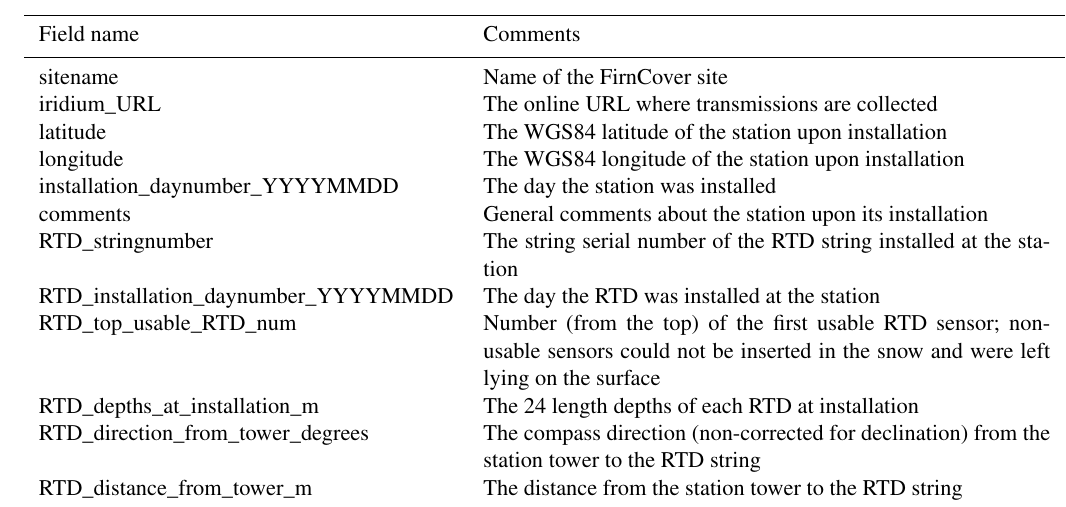
Table A5. Station_Metadata